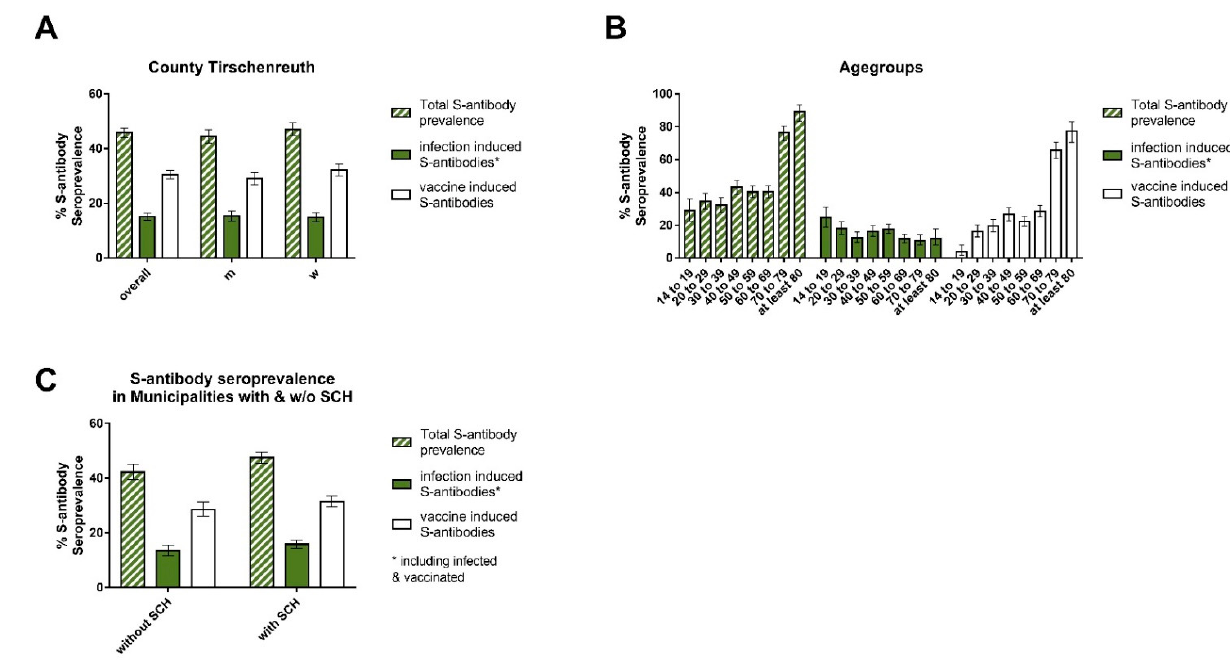
Figure 5. S-specific antibody seroprevalence at FU2. Shown is the standardized S antibody sero- prevalence at FU2 (i) counting all S-antibody positive individuals (total prevalence), (ii) counting S-positives that were also N-positive (infection induced antibodies, including vaccinated and unvac- cinated individuals) or (iii) counting S-positives that were N-negative (i.e., uninfected but vaccinated individuals), in the overall population of Tirschenreuth ( A ), by age-groups ( B ) and for municipalities with or without senior care homes ( C ).